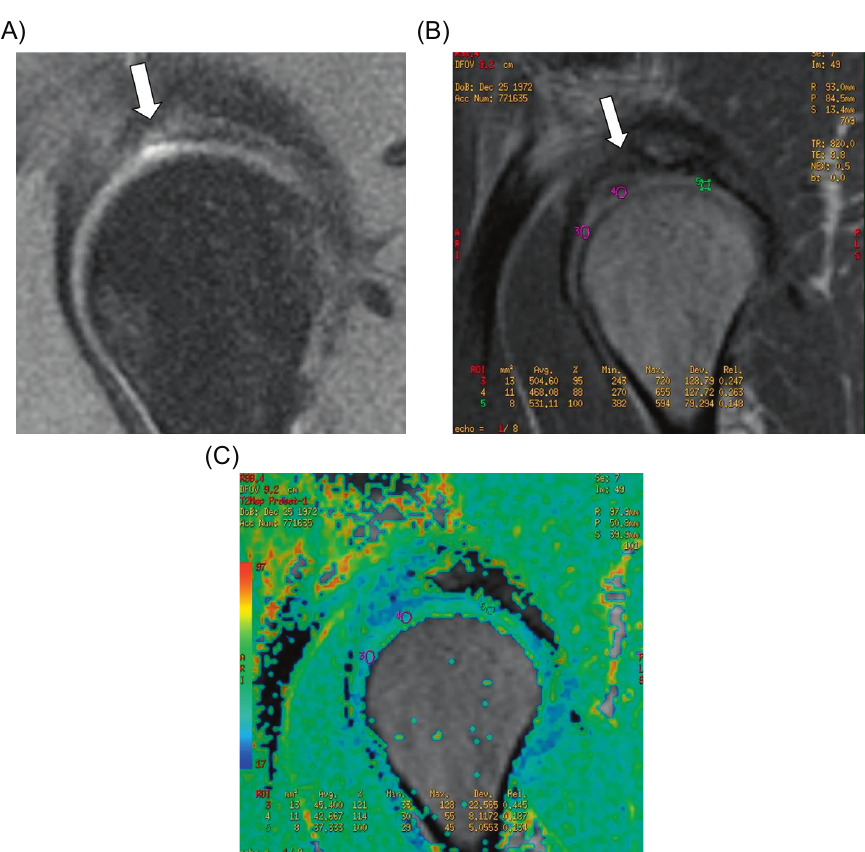
Figure 3. Pre- and post-operative MR of case number 1. The improvement is evaluated quantitatively (100% of filling of the lesion) and qualitatively (decrease in T2 values). (A) PDFS sagital imaging of the right hip showing the absence of cartilage in area of the anterosuperior articular surface of the acetabulum. (B, C) T2 mapping of the same hip 18 months after the surgery and the repair of the ulcerated area with improvement (decrease T2 values, showing mixed fibrocartilage and hyaline